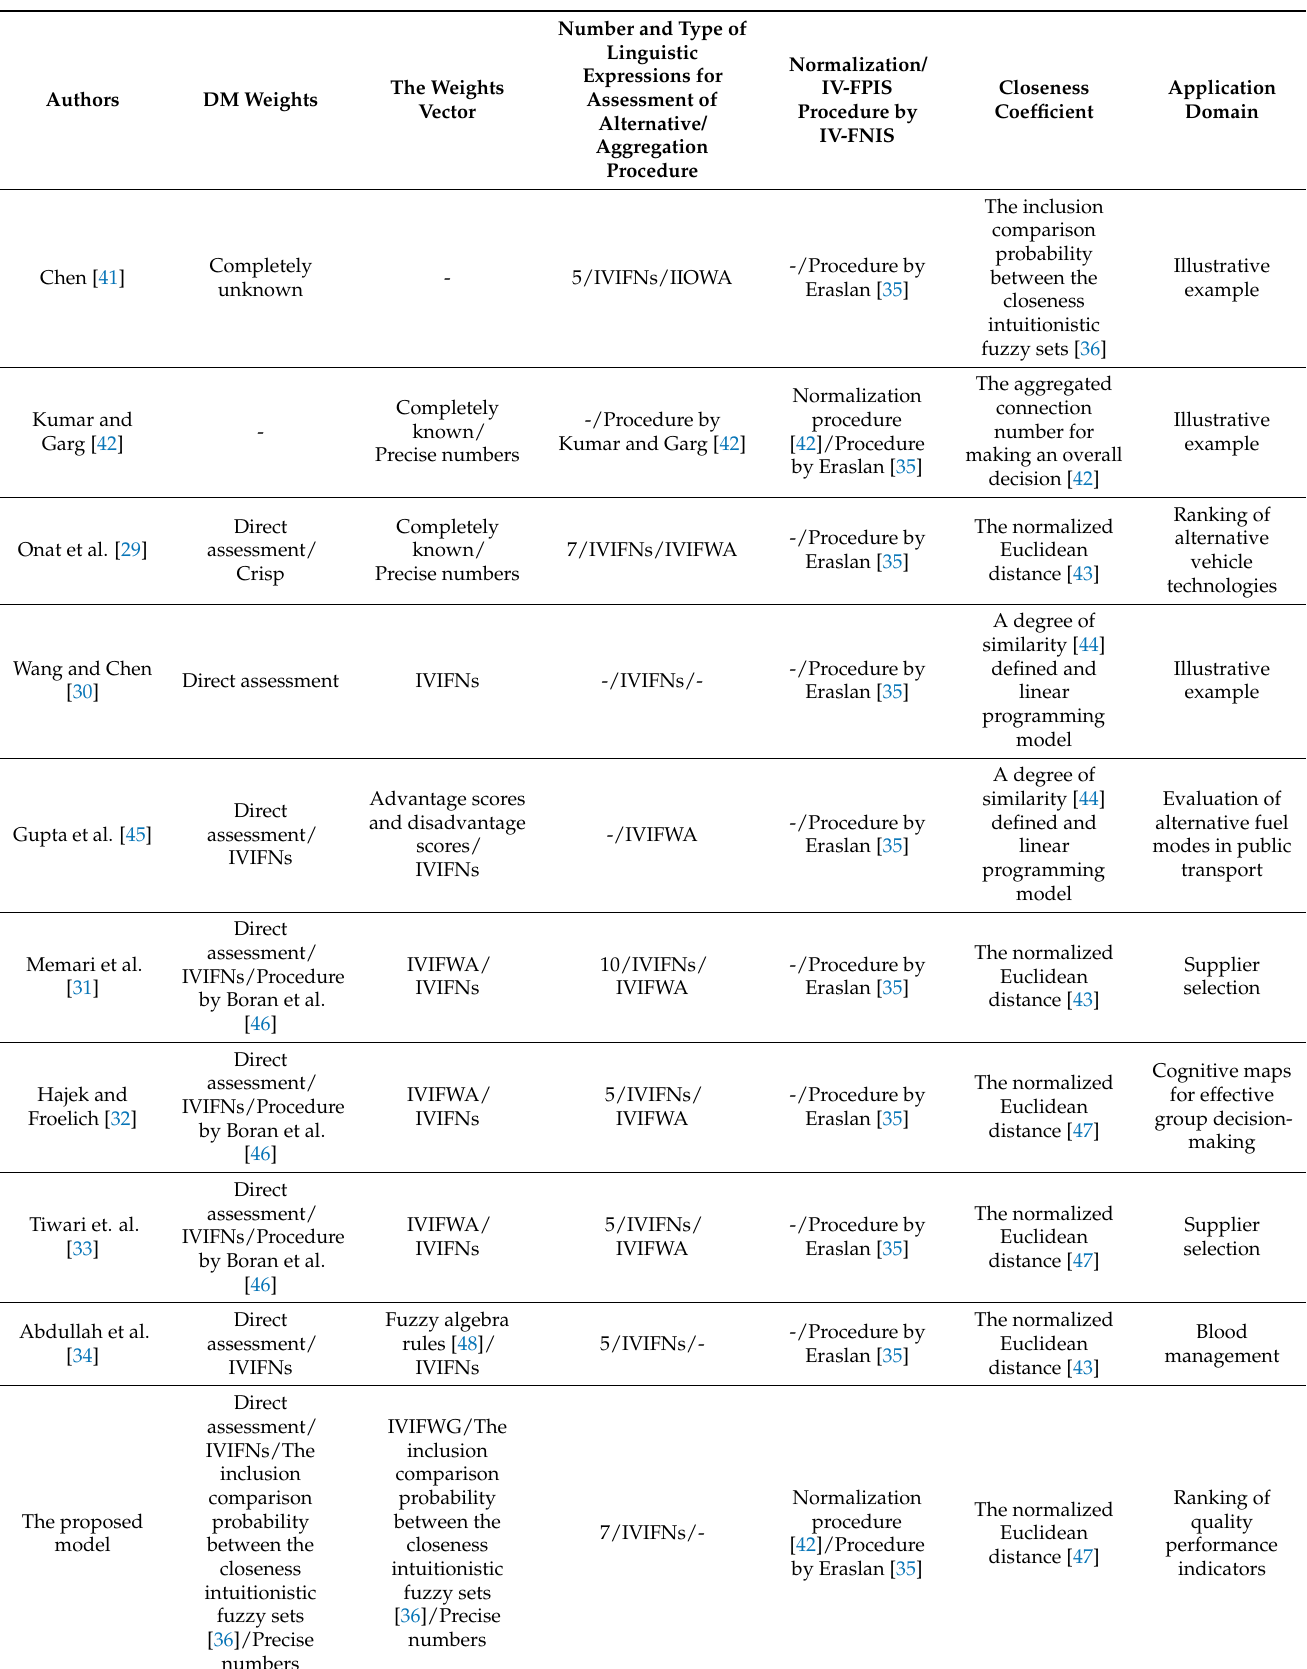
Table 1. Comparative analysis of IV-TOPSIS models from literature sources and the proposed